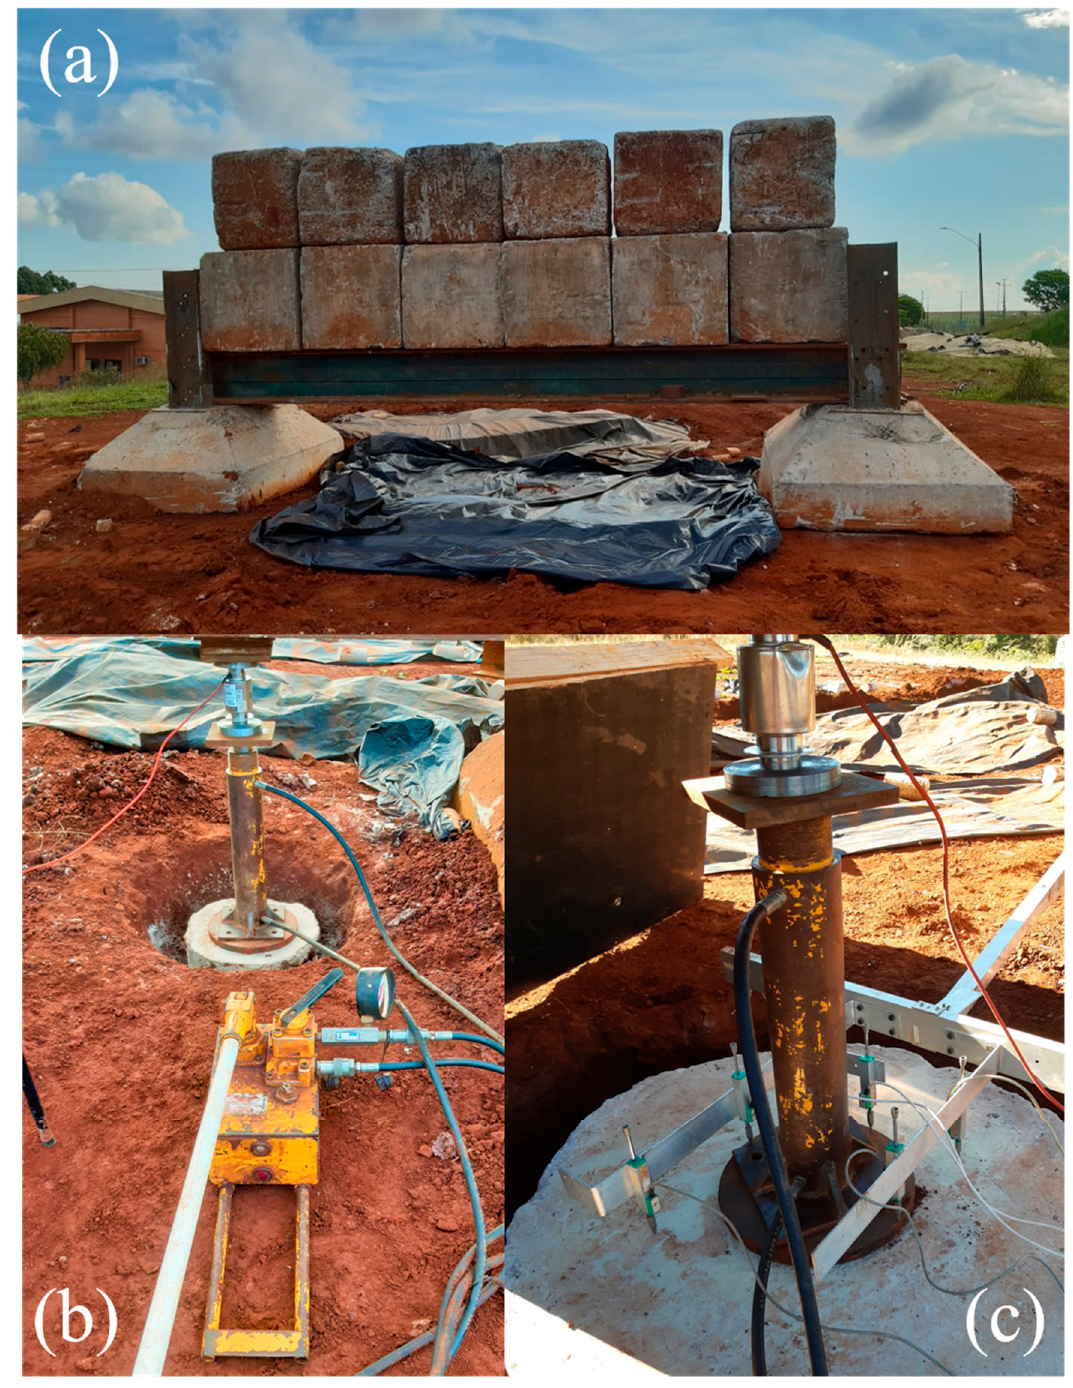
Figure 7. Load application system ( a ) reaction structure; ( b ) load application; ( c ) measurement of the vertical displacement.